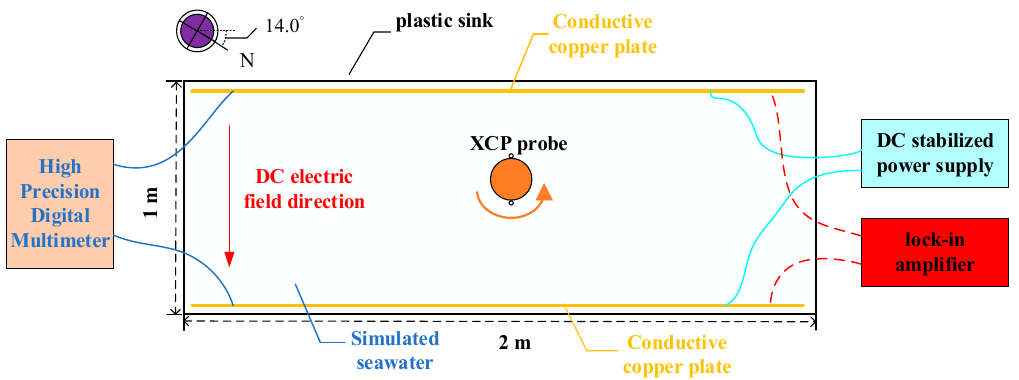
Figure 4. Schematic diagram of the construction of the marine simulation environment.